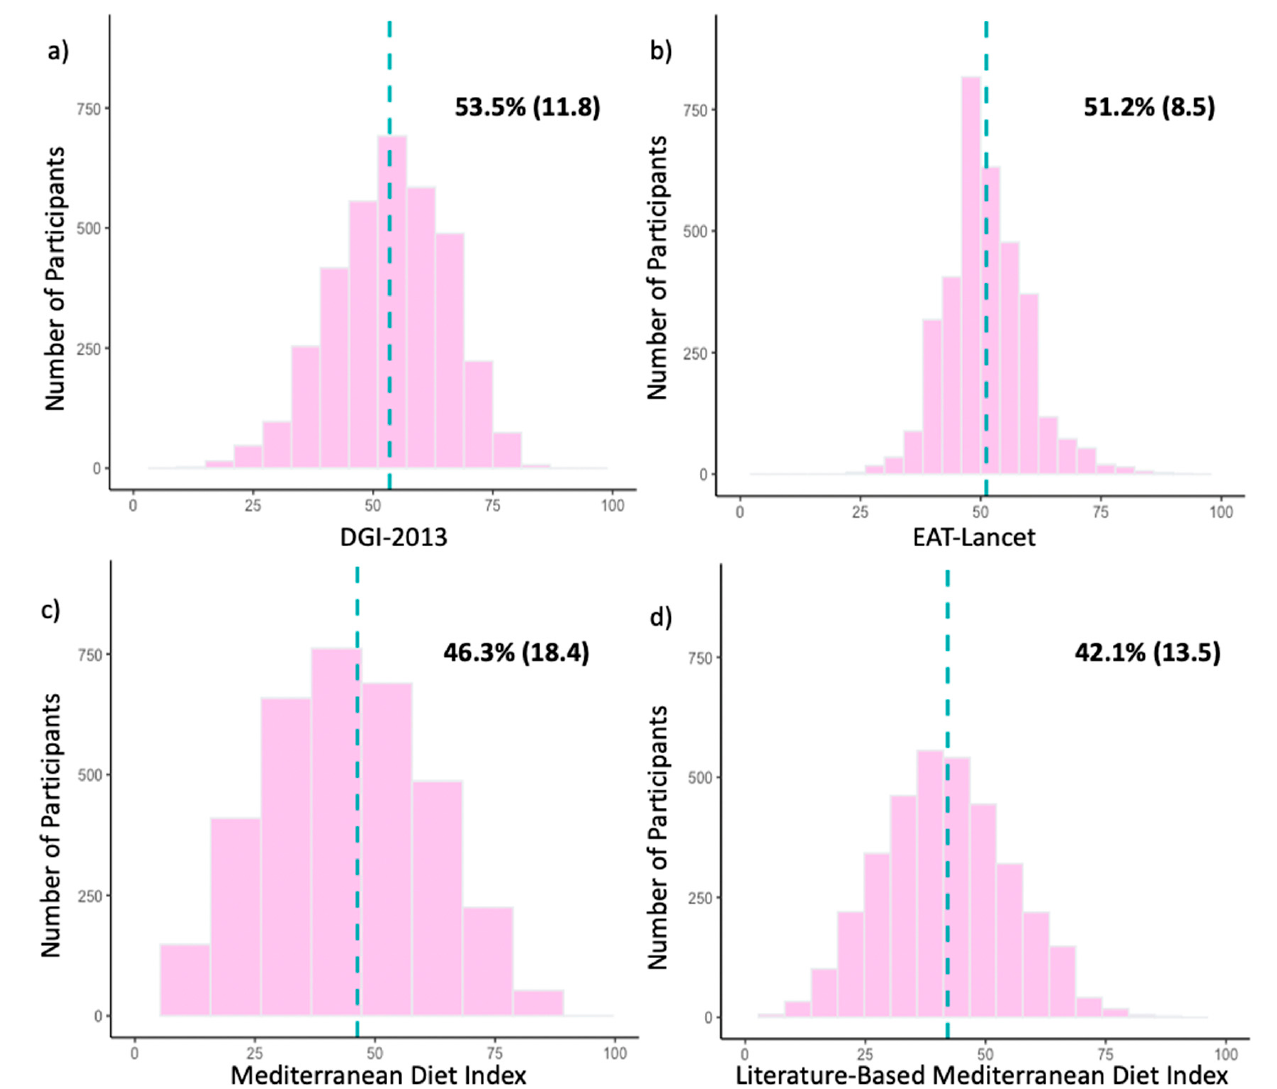
Figure 2. ( a – d ) . Histograms of participant scores for the ( a ) Dietary Guideline Index 2013 (DGI- 2013), ( b ) EAT-Lancet Index, ( c ) Mediterranean Diet Index (MedDiet) and ( d ) Literature-Based Mediterranean Diet Index (Lit-MedDiet) for the whole study population ( n = 3458). For comparison across indices, participant scores are represented as percentages of the maximum possible score for each dietary index. The dotted blue line represents the location of the mean. Mean percentages of participant scores are shown in the upper right-hand area of each histogram, presented as mean (SD). Table 2. Percentage and counts of participants achieving full points for each food group across four dietary indices.